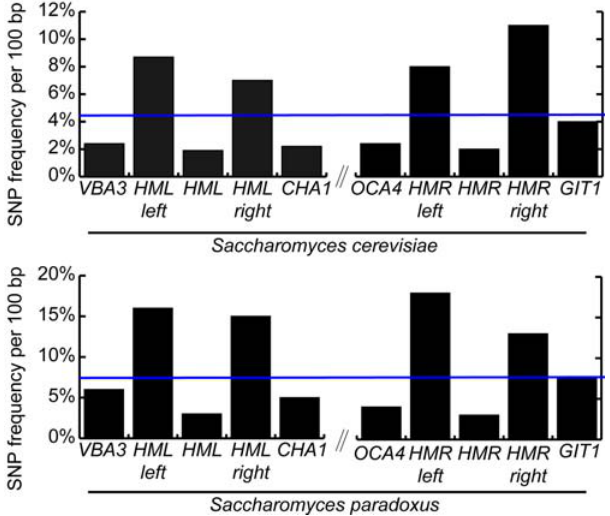
Figure 5. High SNP frequency in S.paradoxus and S.cerevisiae intergenic regions flanking HML and HMR . Average percent of SNPs per indicated region in 37 sequenced S. cerevisiae and in 27 sequenced S. paradoxus strains. The average intergenic SNP frequency in S. cerevisiae was 4.5%, and in S. paradoxus 7% (blue horizontal lines).